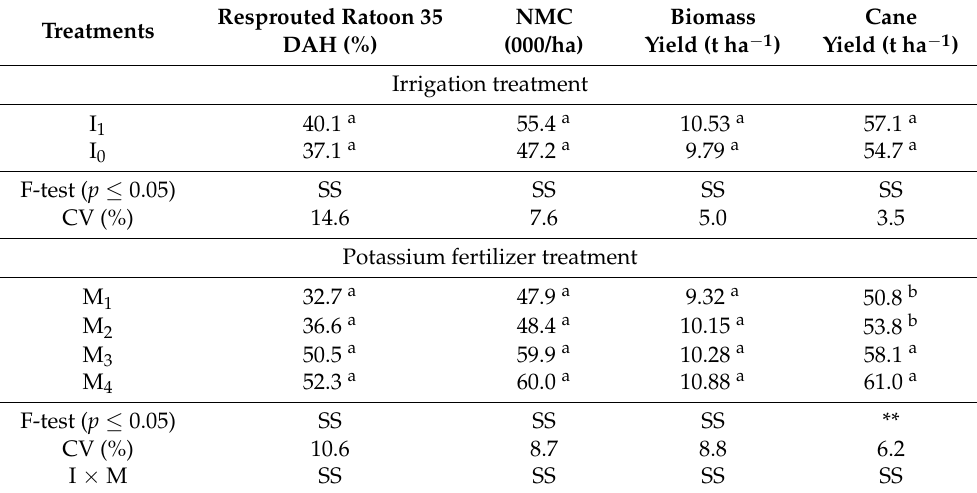
Table 4. Sugarcane resprouting percentage, number of millable canes, and biomass and cane yields under irrigation and potassium